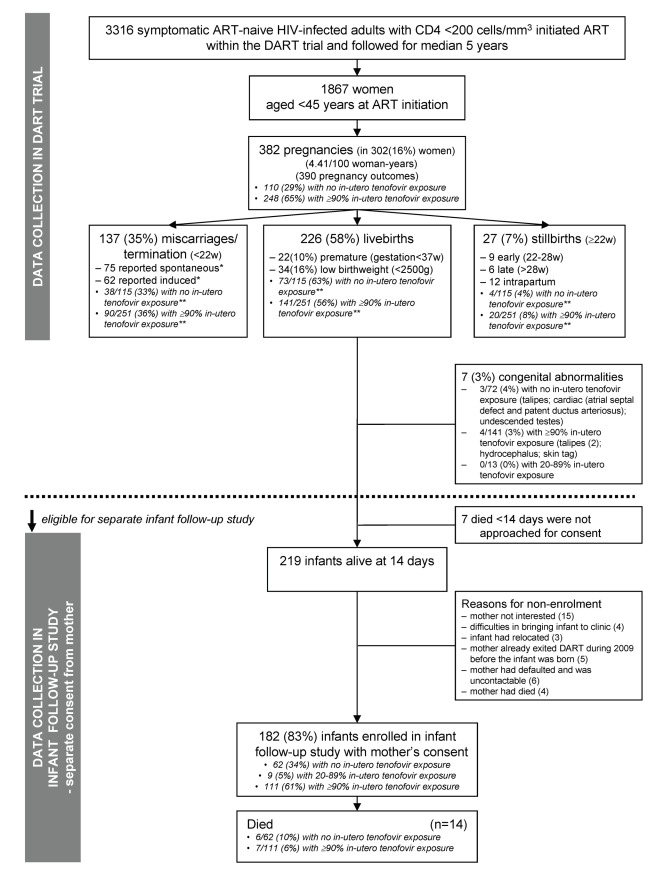
Flow diagram.*, Medical abortion is not generally legal in either Uganda or Zimbabwe. **, More pregnancies on tenofovir occurred in the first 3 y after ART initiation when the proportion of pregnancies ending in miscarriage/termination and stillbirth were higher and rates of live-births were lower.